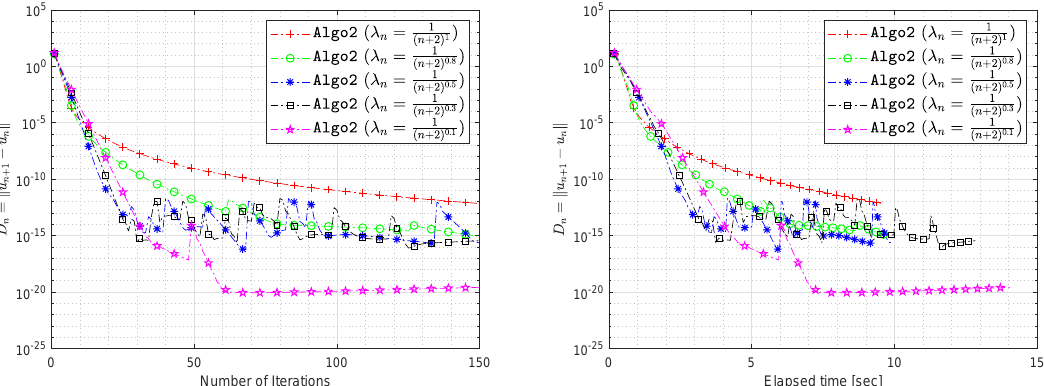
Figure 6. Experiment in Section 6.3.1: Algorithm 2 behaviour with respect to step-size sequences λ n =